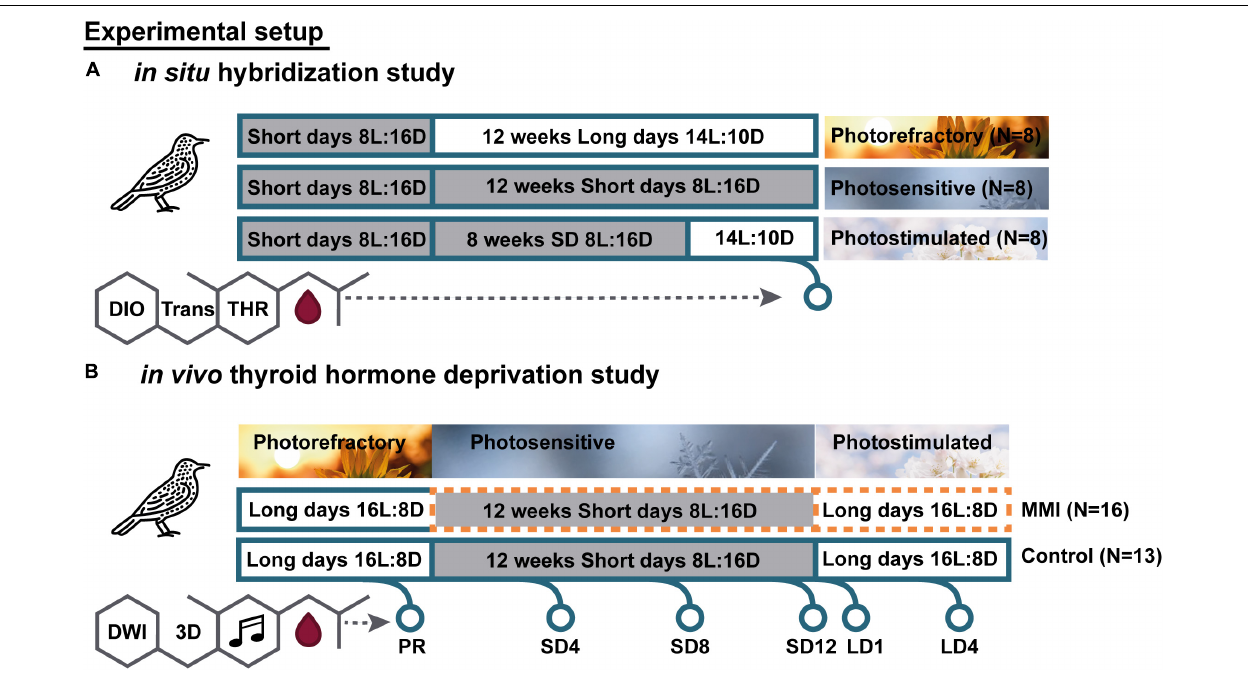
FIGURE 1 | Overview experimental setup of in situ hybridization (A) and in vivo thyroid hormone deprivation (B) study. For in situ hybridization, all birds were photosensitive after being on a short day photoperiod. These birds were divided into three groups with different photoperiodic manipulation: 12 weeks of long days to induce the photorefractory state (PR), 12 weeks of short days to maintain photosensitive state, 8 weeks of short days followed by 4 weeks of long days to induce photostimulated state. For each photoperiod we analyzed different thyroid hormone regulators: deiodinases (DIO), thyroid hormone transporters (Trans), and thyroid hormone receptors (THR). For the in vivo manipulation study, we monitored individual starlings as they went through different photoperiods sequentially and diffusion weighted images (DWI) and 3D MRI scans were acquired at the indicated time points. Short days (SD) are indicated by a gray box. Methimazole (MMI) treatment is indicated by an orange dotted